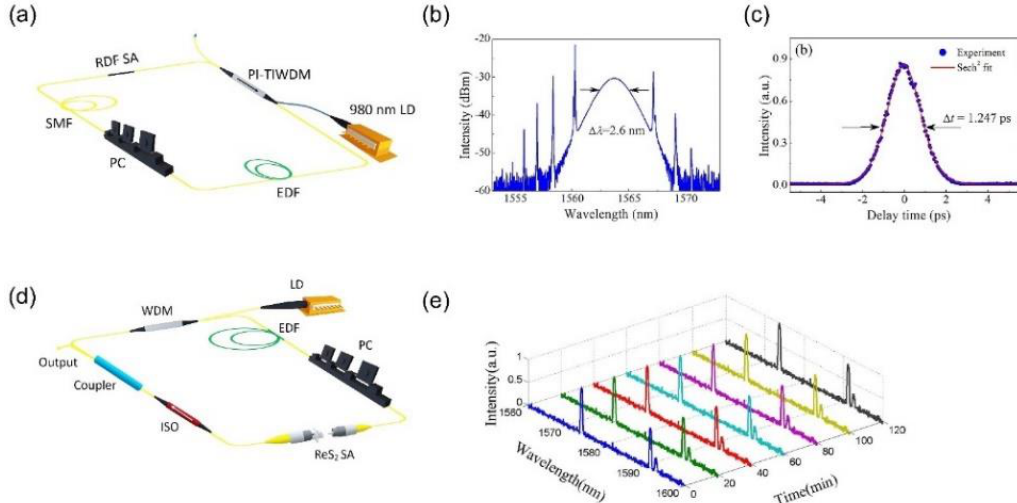
Figure 16. Mode-locked laser pulses at 1.5 µ m. ( a ) Laser setup using ReS 2 -covered D-shaped fiber SA (RDF SA). ( b ) Output Figure 16. Mode- locked laser pulses at 1.5 μm. ( a ) Laser setup using ReS 2 -covered D-shaped fiber optical spectrum with a spectral width ∆ λ of 2.6 nm. ( c ) Autocorrelation trace of the experimental data (dots) and Sech 2 - SA (RDF SA). ( b ) Output optical spectrum with a spectral width Δλ of 2.6 nm. ( c ) Autocorrelation shaped fit (solid curve) ( d ) Laser setup with ReS 2 sandwiched between two fiber connectors to form the SA. ( e ) The corresponding multi-wavelength output with long-term stability over 2 h. ( a ) Adapted under the terms of a Creative